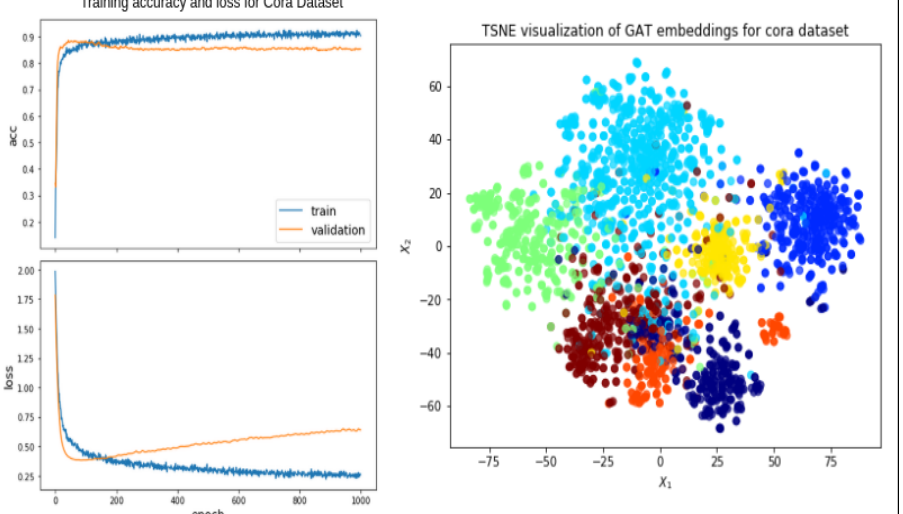
Figure 7. Graphical representation for Cora dataset.